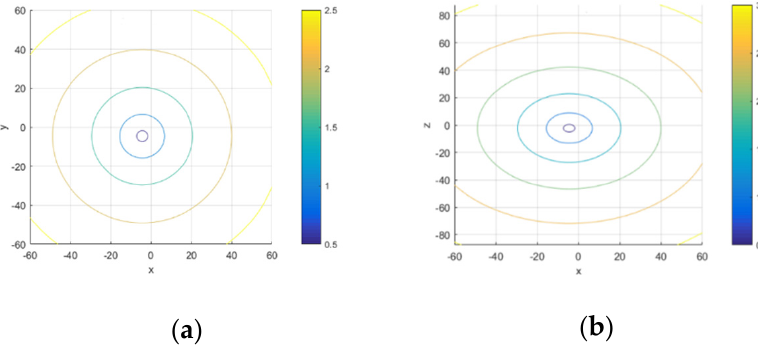
Figure 7. Relationship between location of target with calibrator and TRE: ( a ) Isopleth of TRE at projection of XOY plane; ( b ) Isopleth of TRE at projection of XOZ plane.